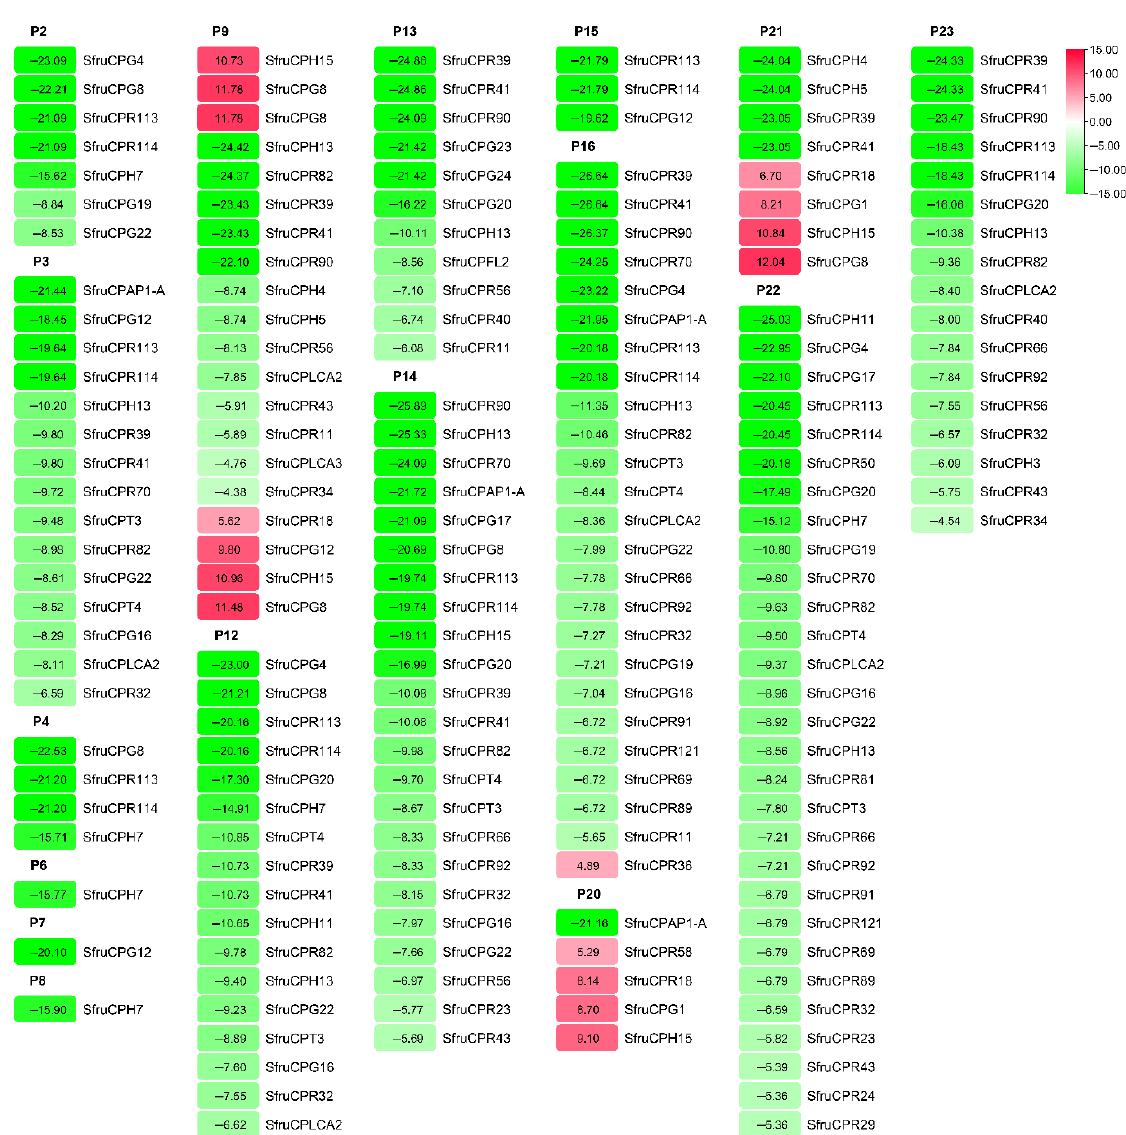
Figure 3. The detailed fold changes of CP genes after exposure to different insecticides. The detailed information of different insecticides corresponding to their codes (above the heat map) are represented in Table 2. Transcriptional levels were expressed as mean fold changes to the control. The red and green colors represent the up and down regulation of CP gene expression by different insecticides, respectively. The detailed fold change values on the left and the differentially expressed CP genes on the right are shown, which are below the insecticide codes.